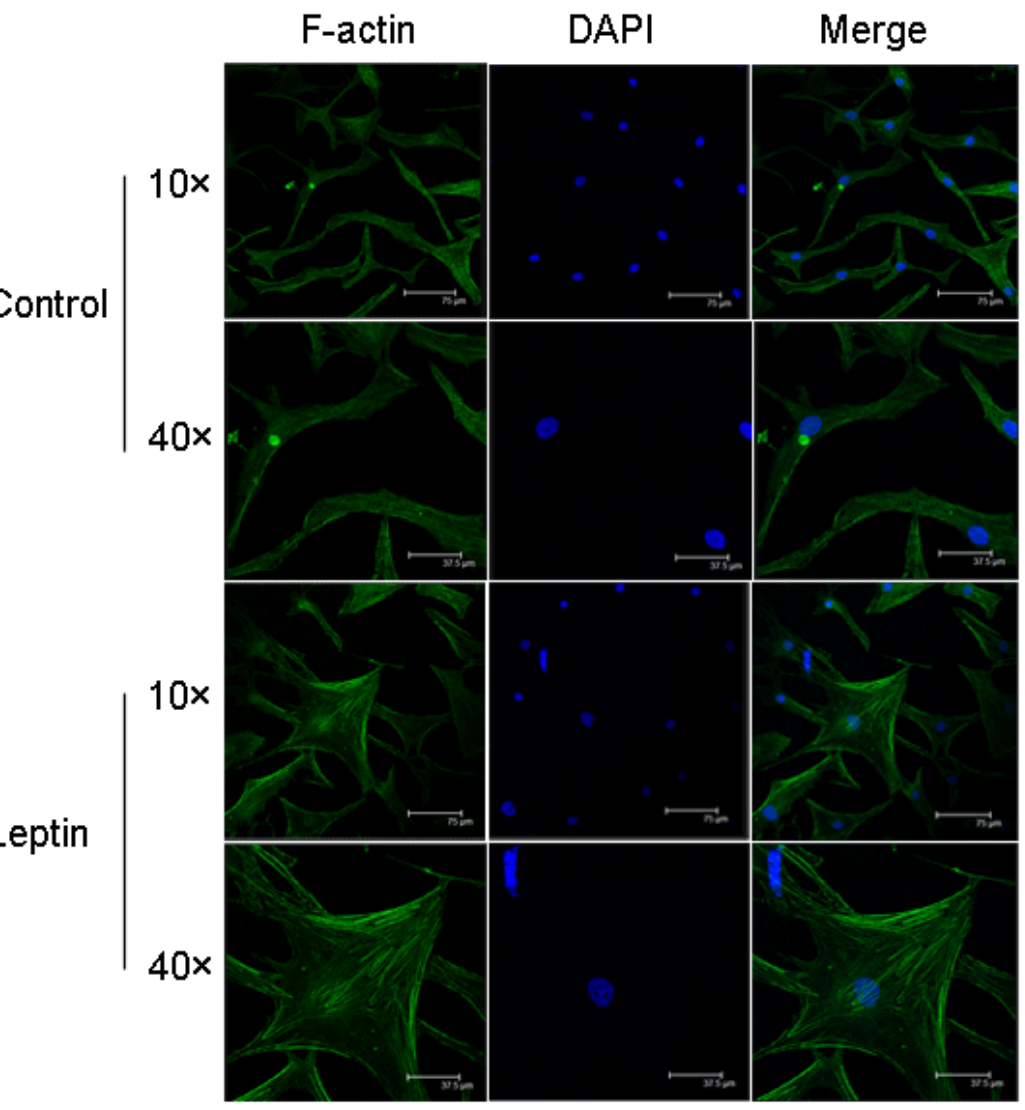
Figure 3. Fluorescence microscopy images showing arrangement of rhodamine-phalloidin-stained ( green ) F-actin filaments in primary human NP cells treated without or with leptin (10 ng/mL). Nuclei were stained with DAPI, shown in blue . Images were acquired using laser scanning confocal microscopy under a 10× and 40× objectives. Control NP cells exhibited diffuse cytoplasmic and perinuclear staining of F-actin while leptin-stimulated NP cells showed strong cytoplasmic filamentous structures. Scale bars represent 75 or 37.5 μ